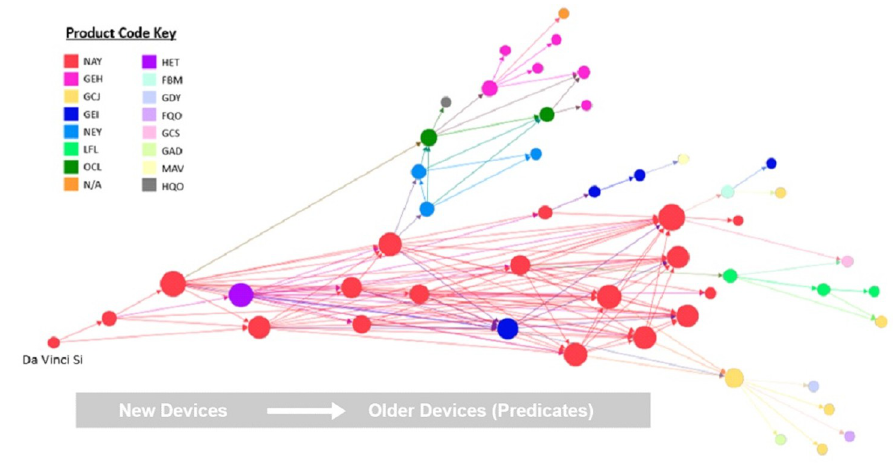
Fig 2. Da Vinci Si trace color-coded by product classification code.